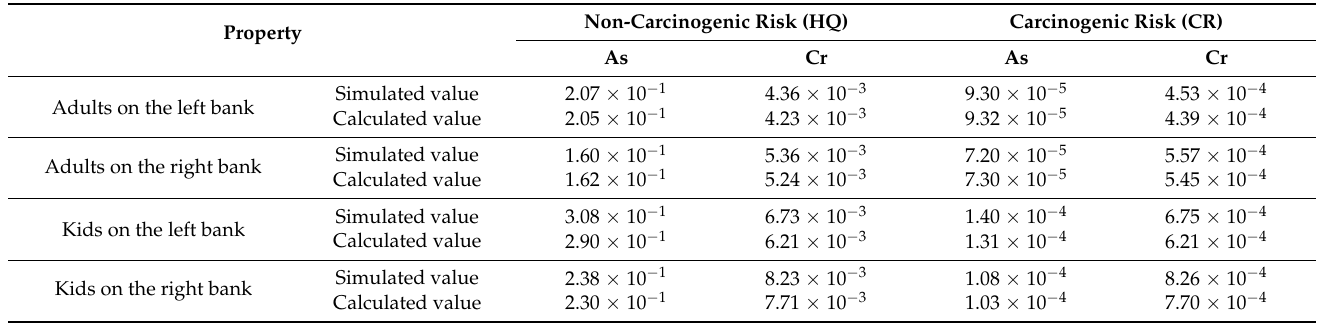
Figure 9. Simulated CR (Cr) values of ( a ) adults on the left bank; ( b ) adults on the right bank; ( c ) kids on the left bank; and ( d ) kids on the right bank. Table 7. Simulated values versus calculated